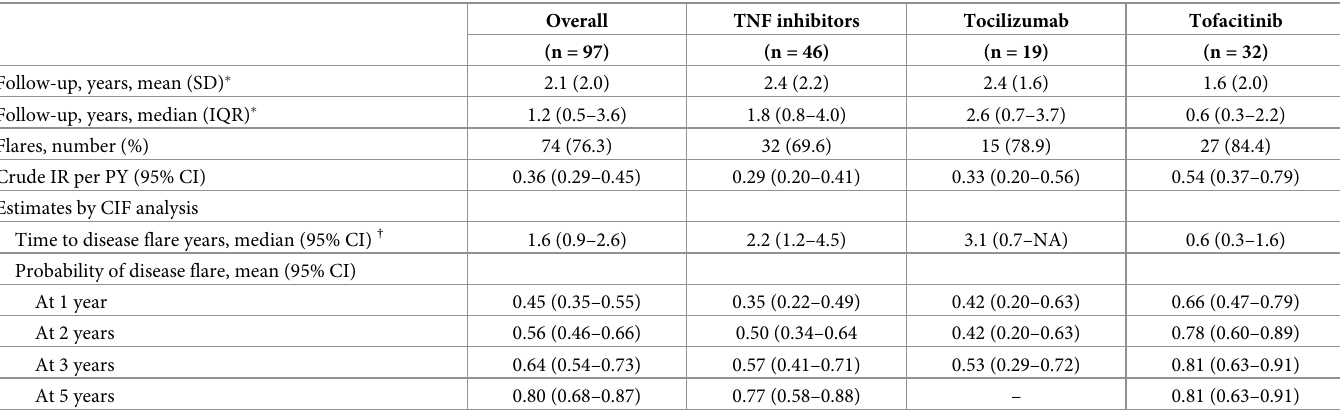
Table 2. Flare of disease activity in RA patients after drug discontinuation.